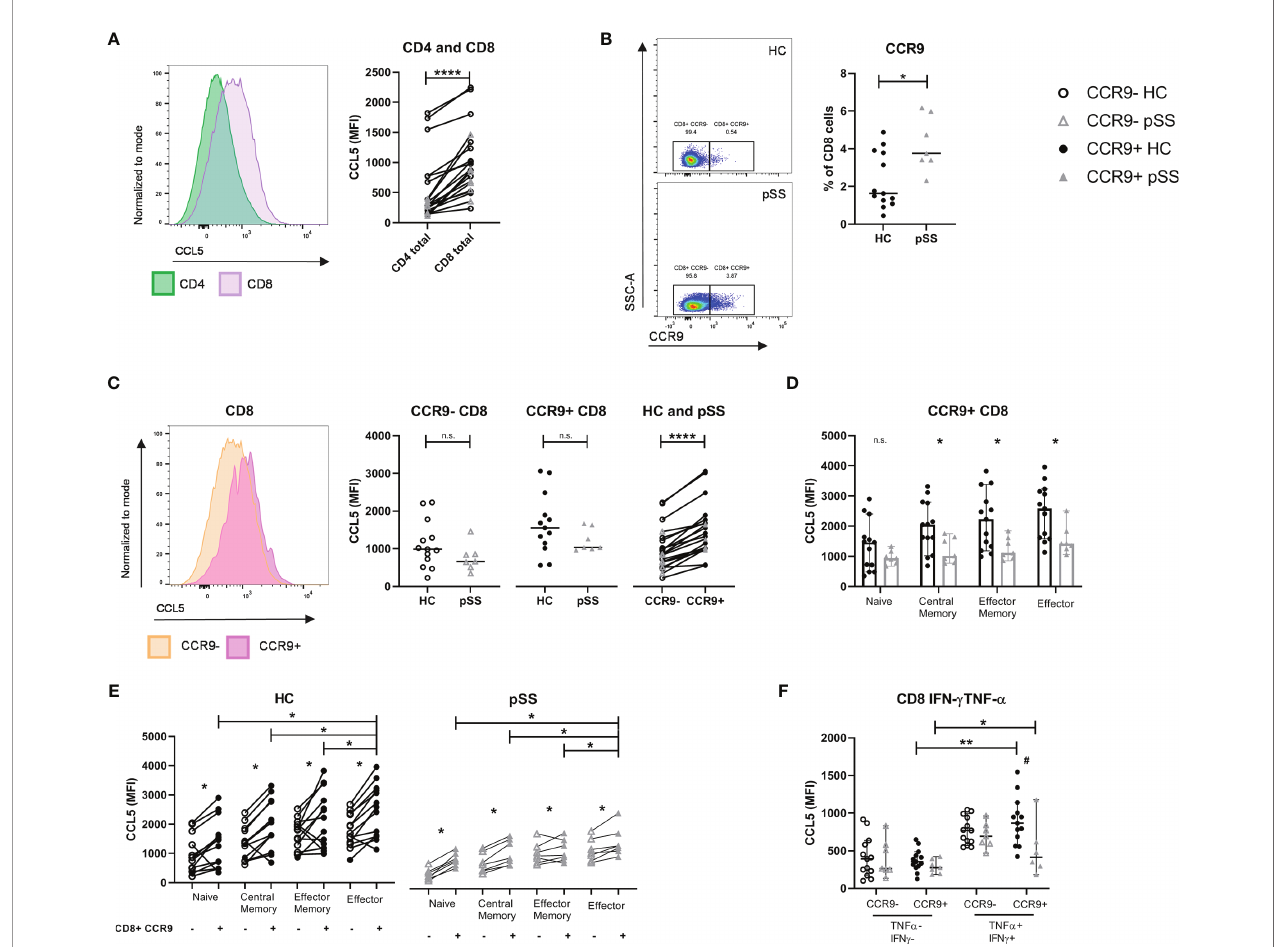
FIGURE 2 | CCL5 expression is highest in CCR9+ CD8 T cells, of which pSS patients have signi fi cantly higher cell numbers. Memory and effector CCR9+ cells from pSS patients express reduced CCL5 levels compared to HC. Flow cytometric analyses comparing for HC (n=13) and pSS patients (n=7). (A) CCL5 expression on CD4 versus CD8 T cells. (B) Percentage of CCR9-expressing CD8 T cells from PBMCs of HC and pSS (representative plots of CCR9 expression from a HC and a pSS patient). (C) CCL5 expression compared for CCR9- and CCR9+ CD8 T cells in HC and pSS patients and between CCR9- and CCR9+ CD8 T cells. (D) CCL5 expression in CD27/CD45RO-de fi ned cell subsets within the CCR9+ CD8 T cells. MFI depicted as median with 95% con fi dence interval. CCL5 expression for HC and pSS comparing CCR9- and CCR9+ CD27/CD45RO-de fi ned CD8 T cell subsets (E) and in IFN- g /TNF- a double negative and double positive CCR9- and CCR9+ T cells (F) . Representative histograms show CCL5 expression normalized to mode. Naive: CD27+CD45RO-; Central Memory: CD27+CD45RO+; Effector Memory: CD27- CD45RO+; Effector: CD27-CD45RO-. MFI, mean fl uorescence intensity; pSS, primary Sjögren ’ s syndrome; HC, healthy controls; PBMCs, peripheral blood mononuclear cells; n.s., not signi fi cant. *, **, **** indicates statistical signi fi cance of p<0.05, 0.01, 0.0001, respectively. # indicates signi fi cant difference with p<0.05 between pSS and HC in (F)